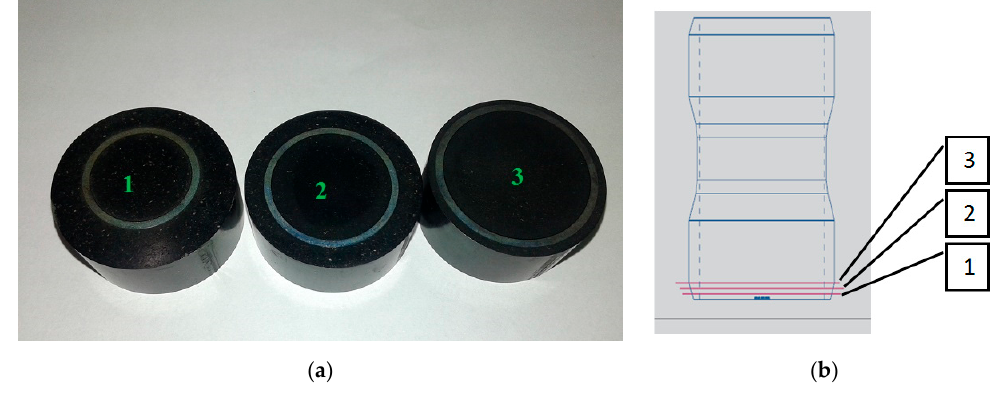
Figure 5. Metallographic test surfaces ( a ) and theirposition in the sleeve ( b ).